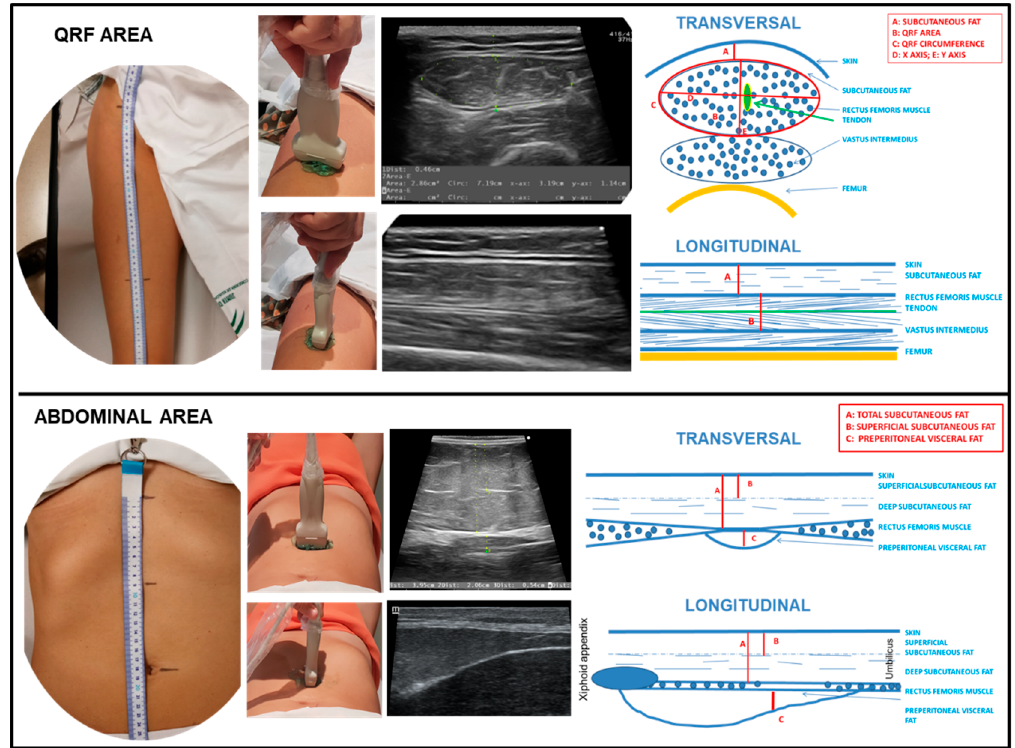
Figure 2. Transversal and longitudinal section of the rectus femoris (QRF) muscle and the abdominal area. Representation of the anatomical measurement area. Position of the ultrasound transducer. Image and scheme of the anatomical structures. To interpret the color references in this figure legend, please see the Web version of this article. Source: own